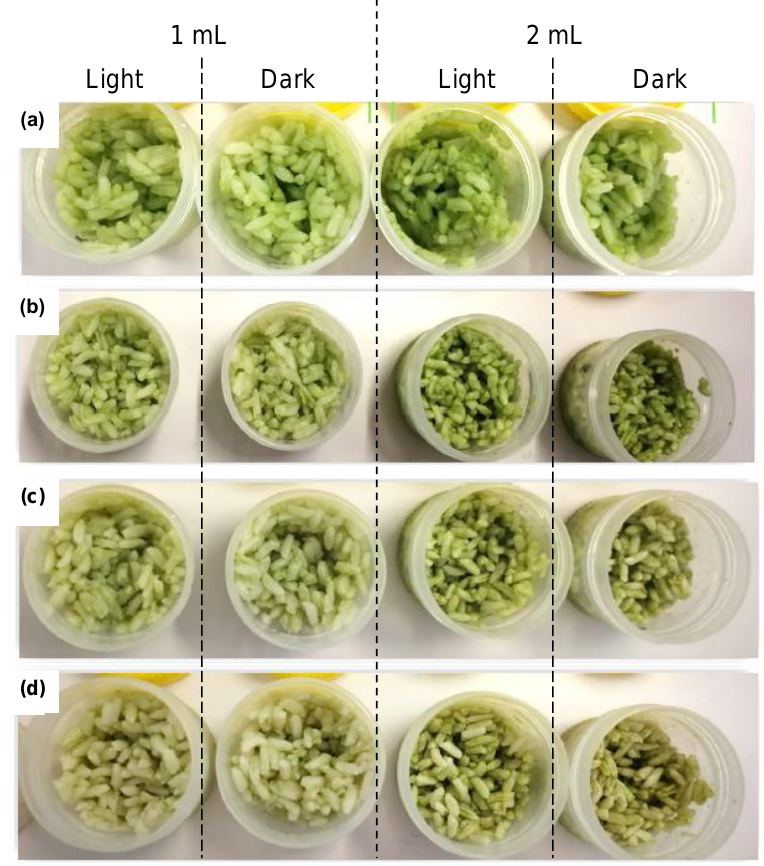
Figure 9. Addition of 1 and 2 mL of C. vulgaris ethanolic extract to white rice and evaluation of visual color during storage at 4 °C in the presence and absence of light at ( a ) day 0; ( b ) day 3; and ( c ) day 7, and ( d ) day 13.